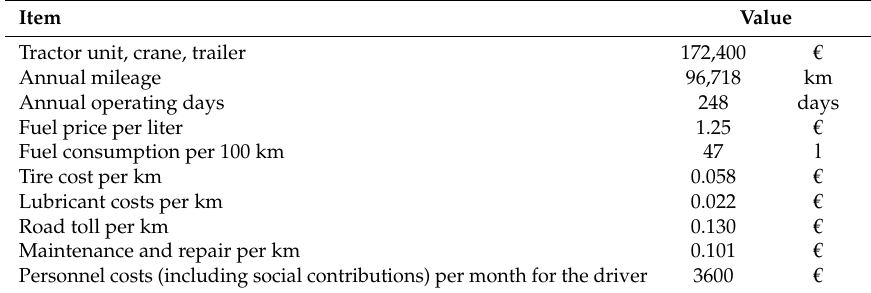
Table 1. General acquisition, operation and personnel costs. Data basis from Reich et al. [26], assuming a price increase of 2% for vehicles since 2015.